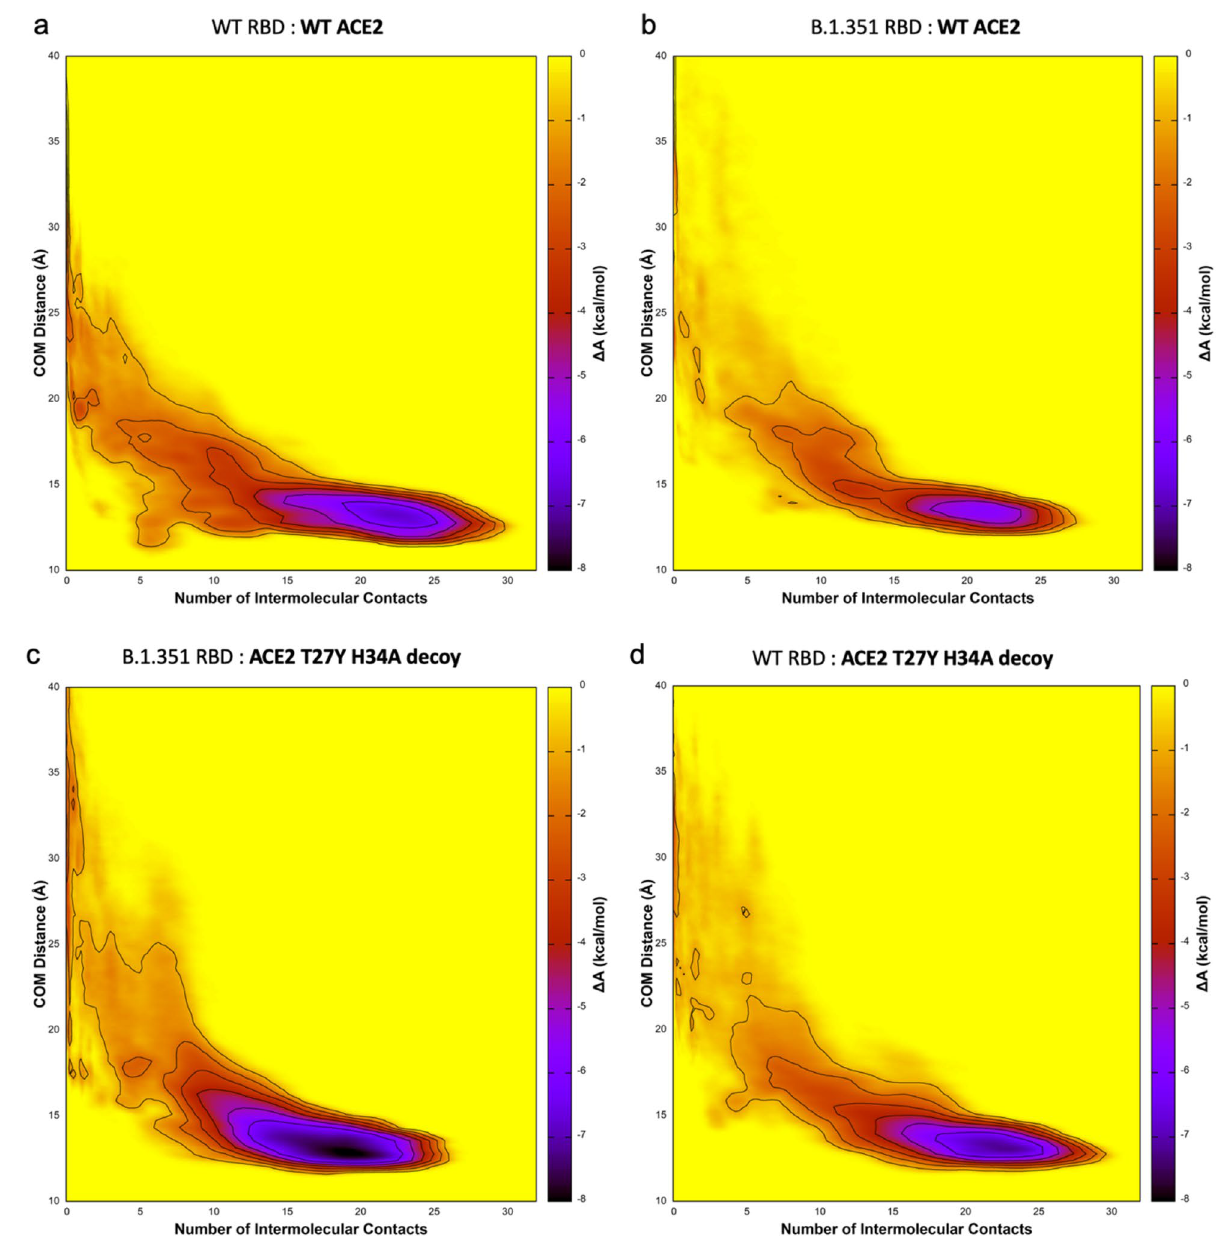
Figure 4. MD simulation predicts highest affinity for the T27Y/H34A decoy to S RBD WT and B.1.351. The free energy surfaces (FES) of wild type (WT) ACE2 upon interaction with ( a ) WT RBD or ( b ) B.1.351 RBD; and FES for the ACE2 T27Y/H34A decoy and ( c ) B.1.351 RBD or ( d ) WT RBD are shown. Darker purple represents lower free energy (ΔA FES , scale at right of each panel). The free energy is a function of the number of intramolecular contacts (x-axis) and the distance between the centers of mass (COM, y-axis) of the interface regions. Binding free energy (ΔA bind ) is estimated by integrating the FES using Eq. (1) in